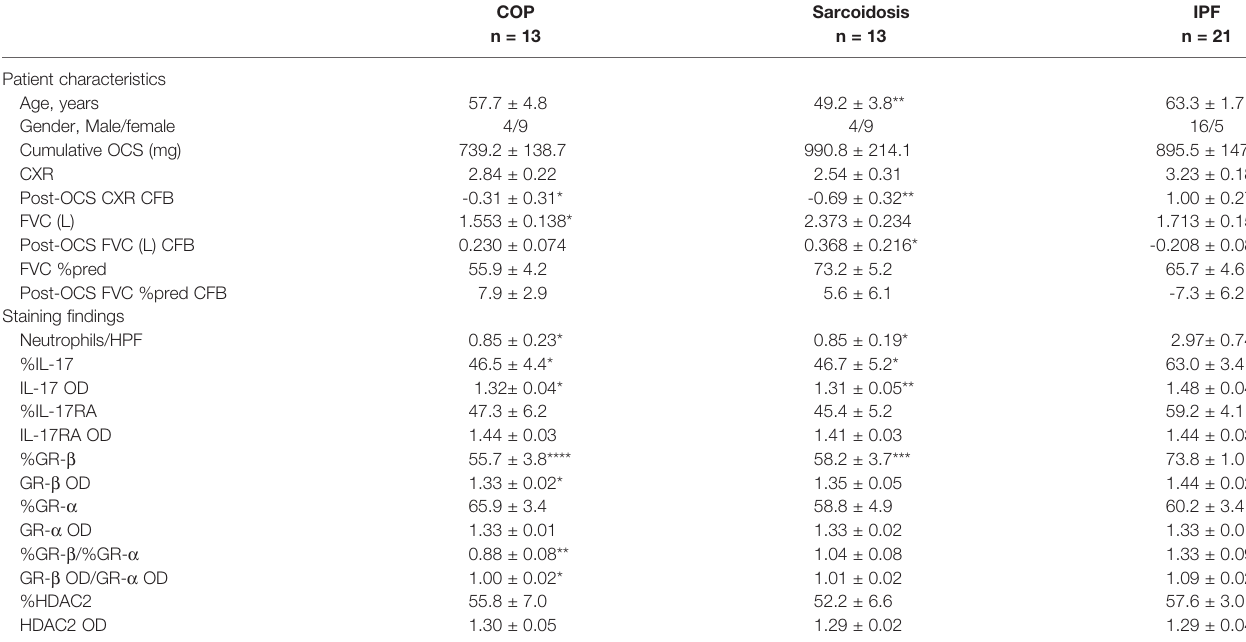
Dataarepresentasmean±SEM.COP,cryptogenicorganizingpneumonia;IPF,idiopathicpulmonary fi brosis;CXR,chestradiographicgradingoftheextentofdisease;CFB,changefrom baseline; OCS, oral corticosteroids; cumulative OCS, cumulative prednisolone or equivalent within 3 continuous months; FVC, forced vital capacity; %pred, percent of predicted value; HPF, high power fi elds (magni fi cation, x400); IL-17, interleukin-17; IL-17RA, interleukin-17 receptor A; GR, glucocorticoid receptor; HDAC2, histone deacetylase 2; OD, opacity density. *P < 0.05, **P < 0.01, ***P < 0.001, ****P < 0.0001 versus